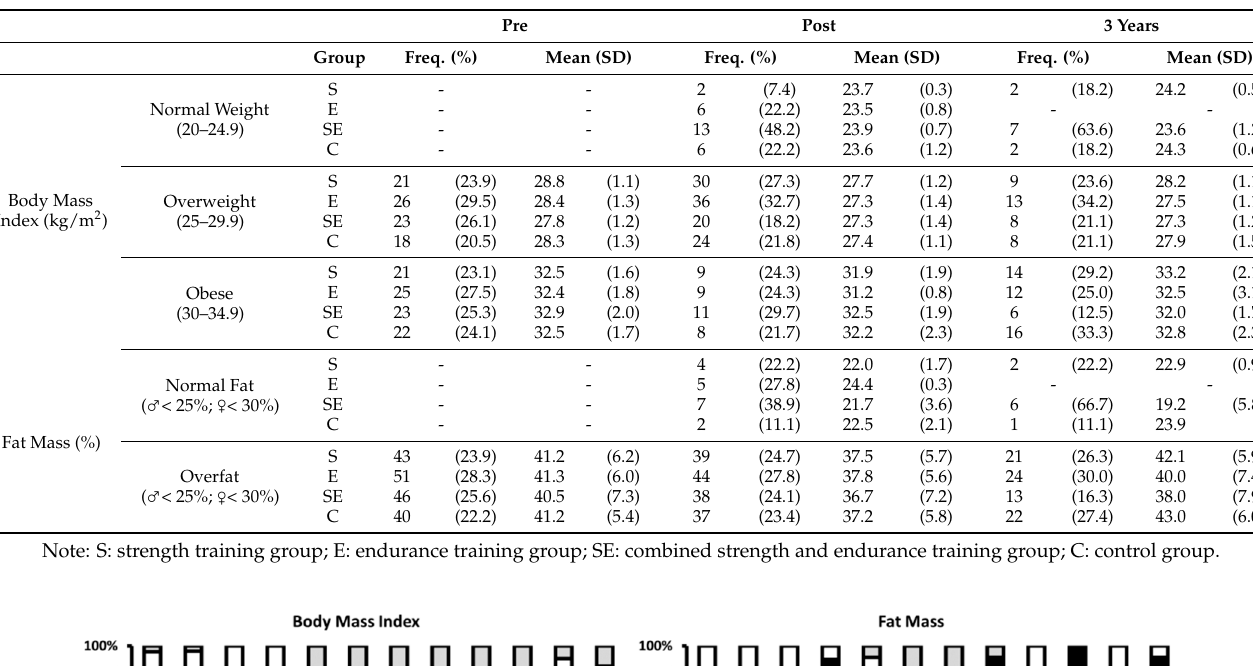
Table 2. Prevalences of normal weight, overweight, and obese participants, as well as prevalence of normal fat or overfat participants at pre-intervention, post-intervention, and 3 years after intervention by group.